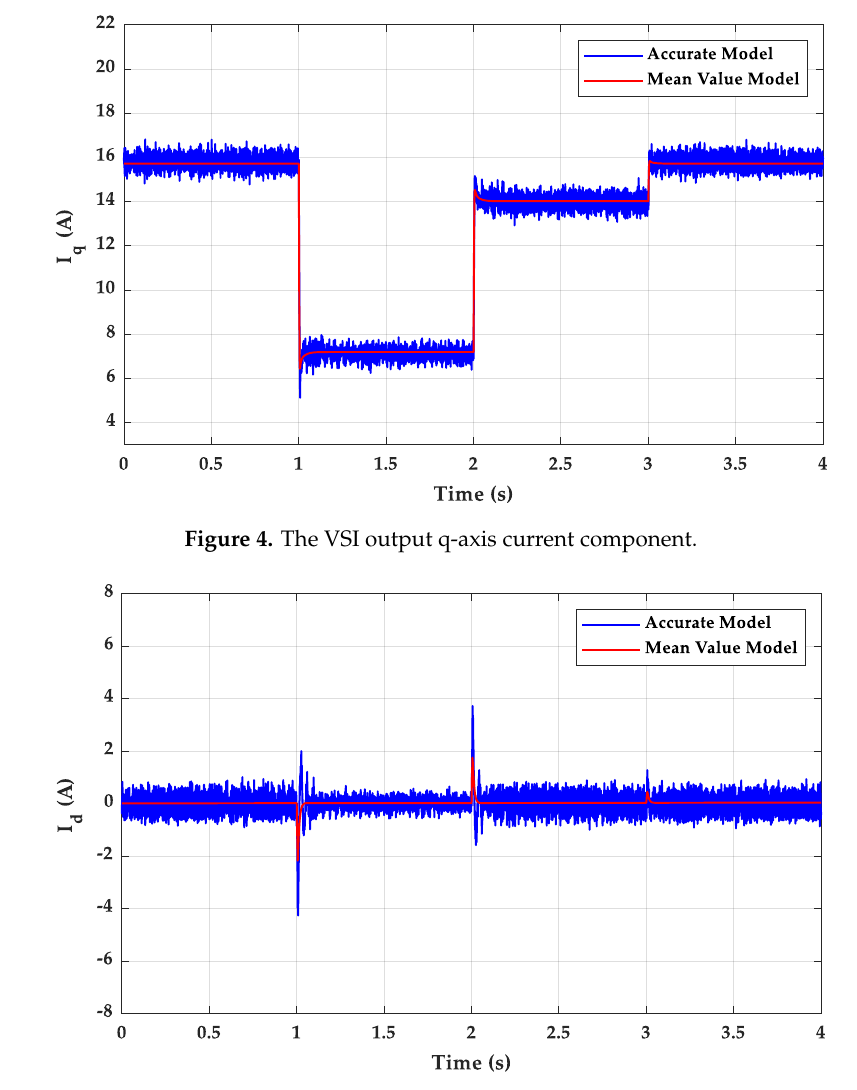
Figure 6. The dc-side voltage response.